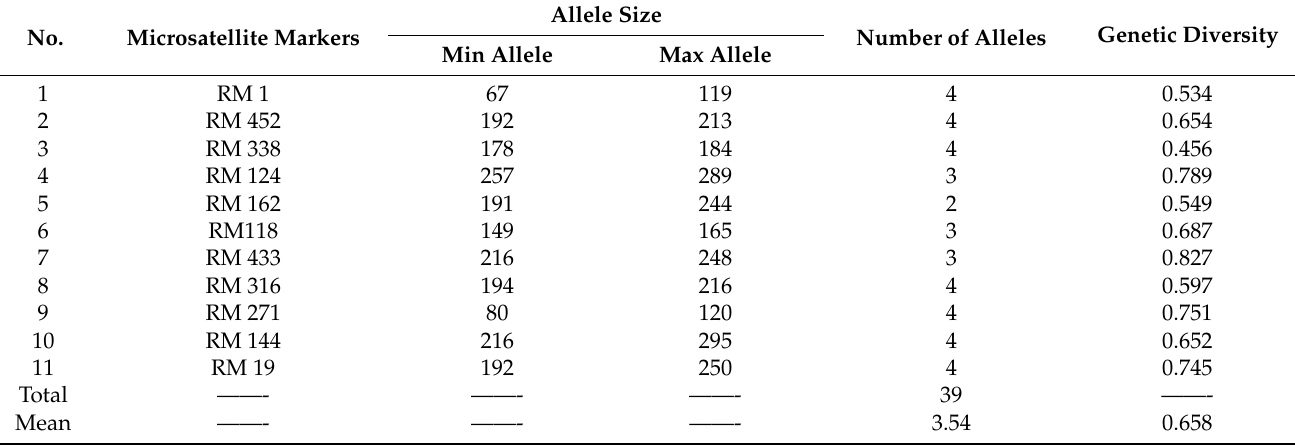
Table 1. Description of 11 rice microsatellites, their chromosomal location, allele size and number of alleles.